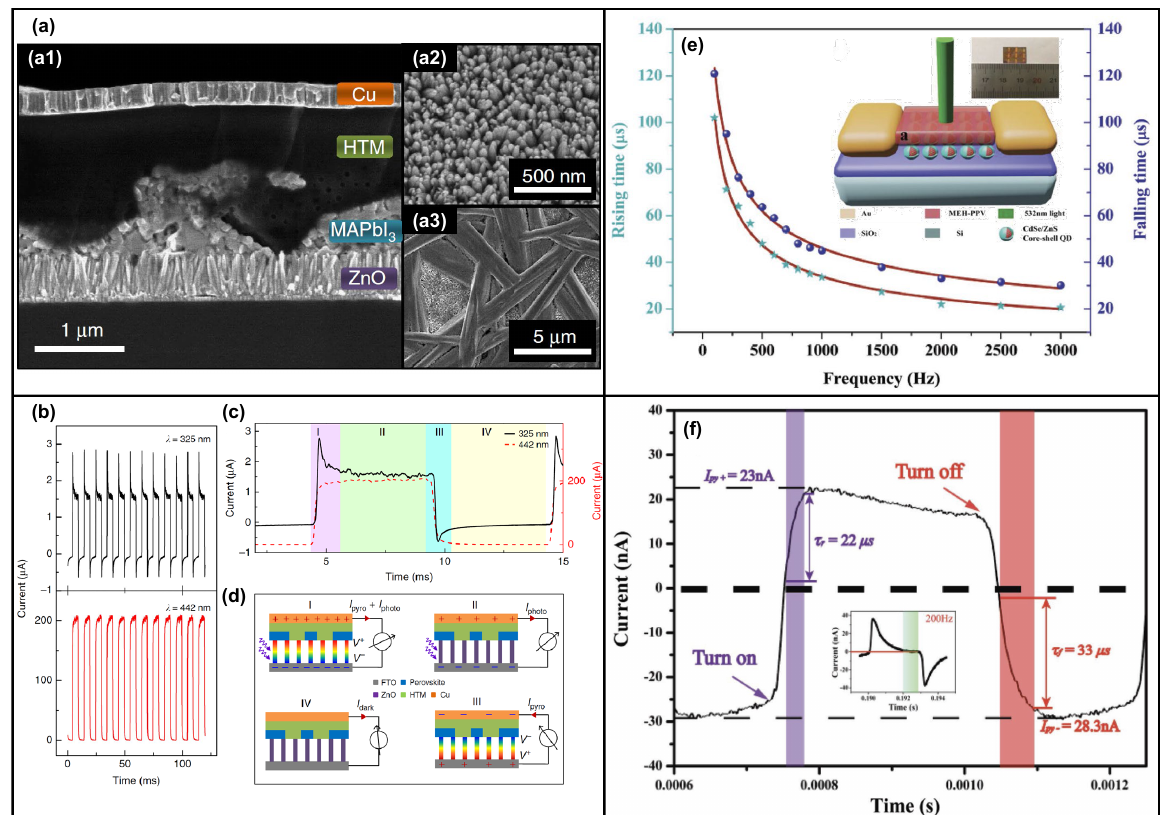
Figure 1. ( a ) SEM images of the as-fabricated perovskite/ZnO nanowires heterojunction; (a1) Cross- sectional view of the heterojunction, clearly showing the separate layers; (a2) Top view of the as- grown ZnO nanowires; (a3) Top view of the spin-coated perovskite on ZnO nanowires; ( b ) The transient photocurrent of the heterojunction in response to 325 and 442 nm laser illuminations, clearly presenting photocurrent peaks while the illumination turns on and off only in 325 nm con- dition; ( c ) The enlarged transient photocurrent from ( b ) to show detailed differences in transient photocurrent dynamics between 325 and 442 nm laser illuminations; ( d ) The proposed fundamental working mechanism of pyro-phototronic effect; ( e ) The rising and falling times as a function of chopper modulating frequency of the 0D CdSe/ZnS core-shell QD based device. It clearly shows a decreasing trend with increasing frequency. The inset is a schematic of the 0D CdSe/ZnS core-shell QD-based device; ( f ) The transient photocurrent response of the 0D CdSe/ZnS core-shell QD-based device to 532 nm illumination, showing distinctive photocurrent peaks while the light turns on and off. Reproduced with permission from [27]. Copyright 2018 Wiley.